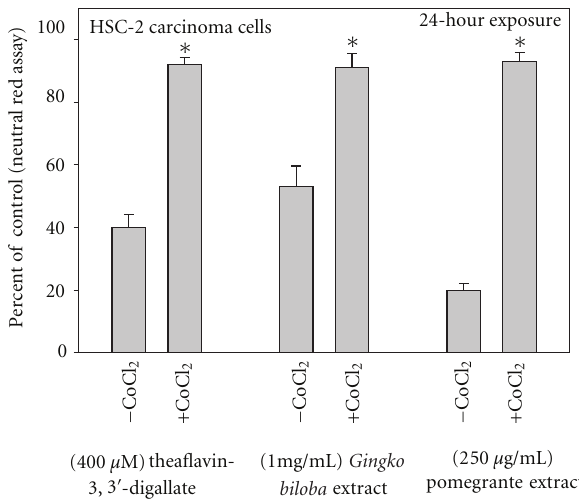
Figure 7: Comparative toxicities of theaflavin-3,3 (cid:2) -digallate, Ginkgo biloba extract, and pomegranate extract towards human oral HSC-2 carcinoma cells, untreated (control) and treated with cobalt chloride. Cell proliferation was quantified with the neutral red assay, a cell viability assay. Data are presented as the mean percent of control ± S.E.M. Data for the theaflavin-3,3 (cid:2) -gallate are from Schuck et al. [19], for G. biloba extract from Babich et al. [13], and for pomegranate extract from Weisburg et al.